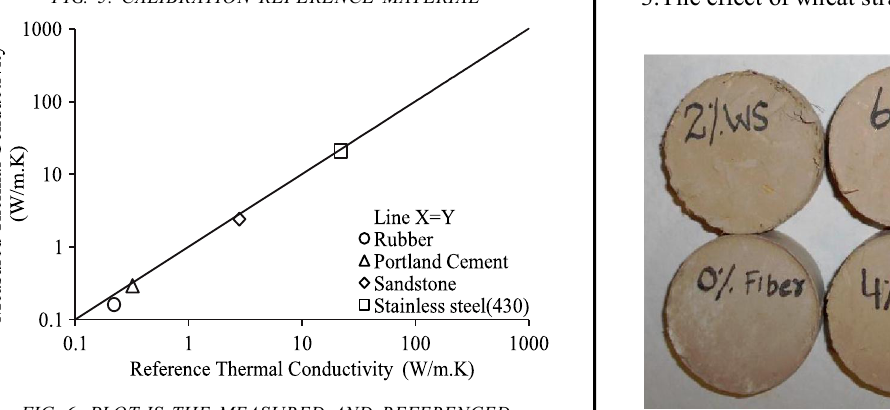
FIG. 6. PLOT IS THE MEASURED AND REFERENCED THERMAL CONDUCTIVITY VALUES FIG. 7. CLAYEY SAMPLE MIXED WITH WHEAT STRAW TABLE 3. EFFECT OF WHEAT STRAW CONTENT ON THERMAL CONDUCTIVITY/